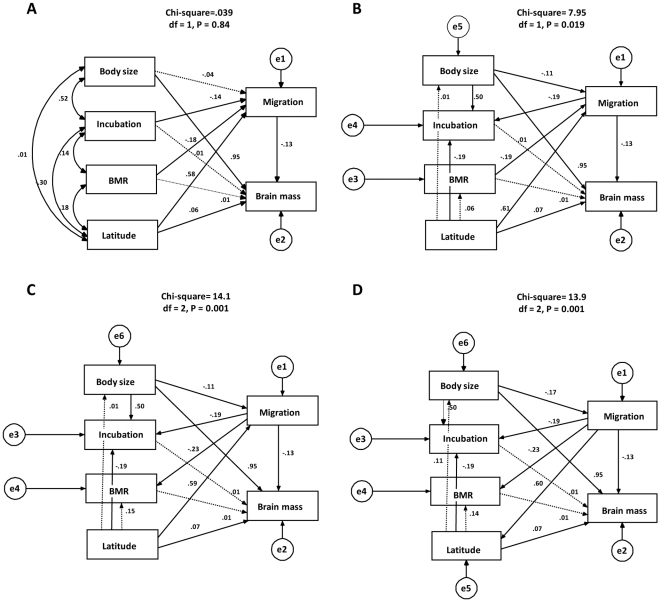
Four best path models (A–D) deconstructing direct, indirect and spurious effects in the relationship between brain mass and migratory distance.The path coefficients and fit of the models were calculated based on the correlation matrix of raw values from all species (600 species), with means and intercepts estimated to deal with missing values [63]. Solid lines indicate the paths that are significant at P<0.05. All path coefficients that are significant are also significant when tested with the phylogenetic generalized least squares approach. Brain mass (Brain), body mass (Body) and incubation period (Incubation) were log transformed to improve normality. Although migration distance (Migration) is measured in an ordinal scale (see methods), the residuals from the model in which this variable is used as response variable fit well to a normal distribution. The terms e1–e6 refer to the error terms.